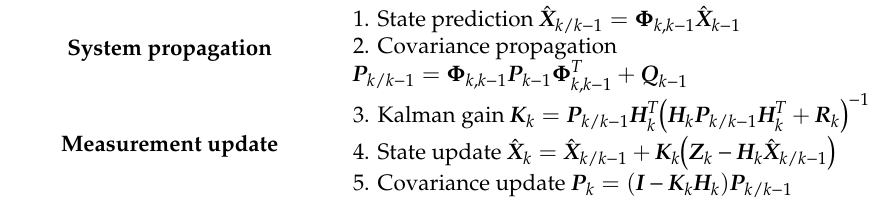
Table 1. Classical Kalman filter (CKF) process